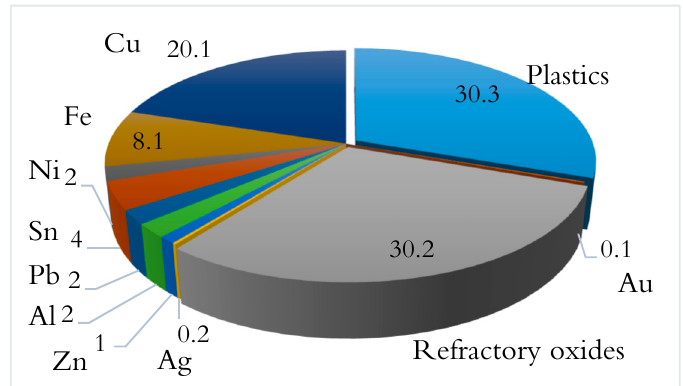
Figure 1. Characteristic material composition of waste electric and electronic equipment (WEEE); values are in percent, adapted from [5].